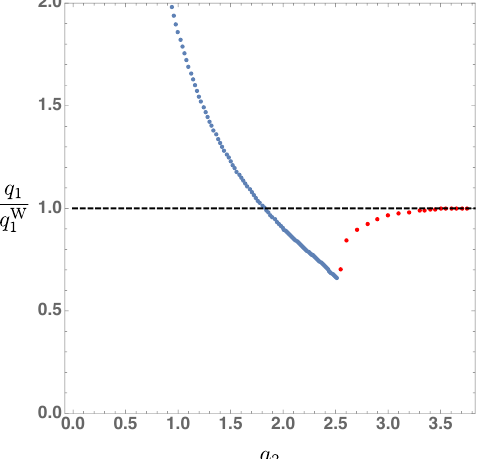
as a function of a 2 , for a 1 = 3 a 2 , q 1 = 4 = r =0 , and the orange squares to hO 2 ij r =0